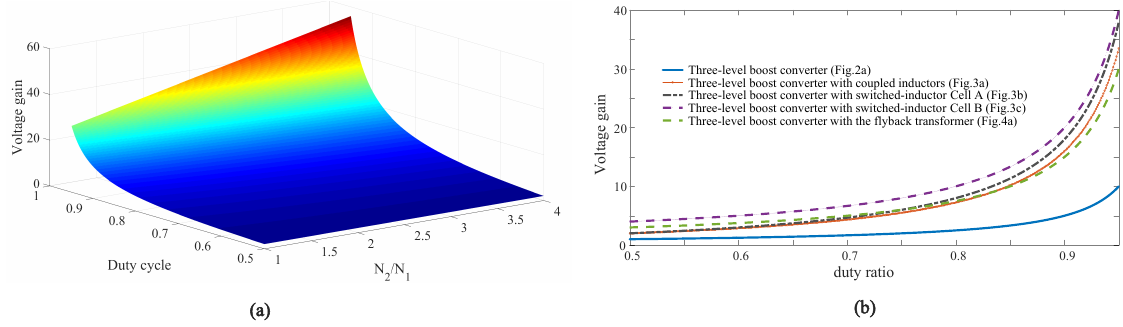
Three-level boost converter (Fig.2a) Three-level boost converter with coupled inductors (Fig.3a) Three-level boost converter with switched-inductor C ell A (Fig.3b) Three-level boost converter with switched-inductor C ell B (Fig.3c) Three-level boost converter with the flyback transformer (Fig.4a)